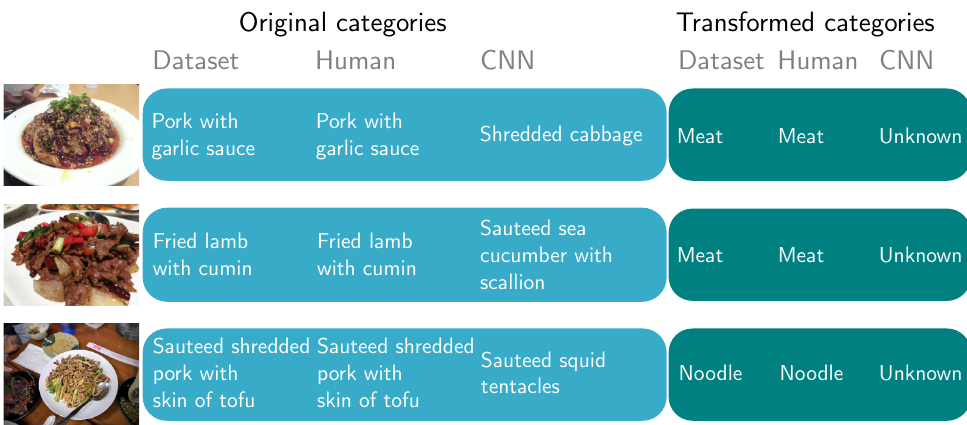
Figure 14. Classification of selected images from VireoFood-172 dataset [58] by ENG population. When using original categories CNN classification are different from true categories. Images are only examples to visually represent a dataset category. They are not part of the dataset. <pork with garlic sauce> photo by Irrational cat and <fried lamb with cumin> photo by Alchen_x licensed under CC BY-SA 2.0, <sauteed shredded pork with skin of tofu> photo by T. Tseng licensed under CC BY